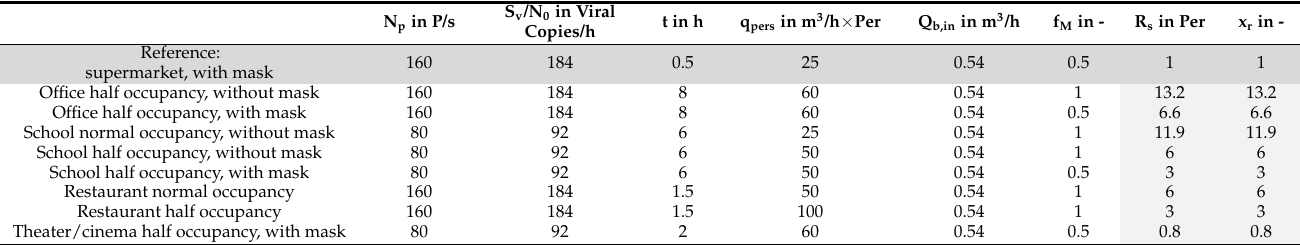
Table A5. Comparison of different situations with the simplified approach.